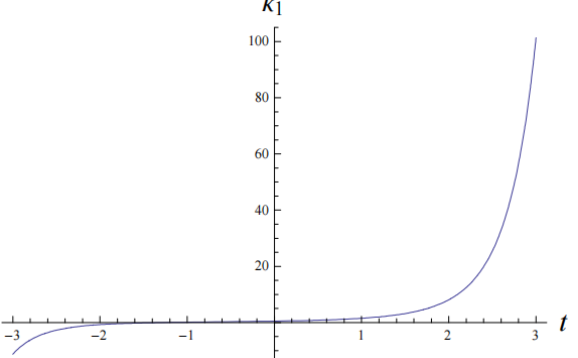
κ in Equation (121). Figure 1. Nonlinear dynamical evolution of the spectrum κ 1 in Equation 1